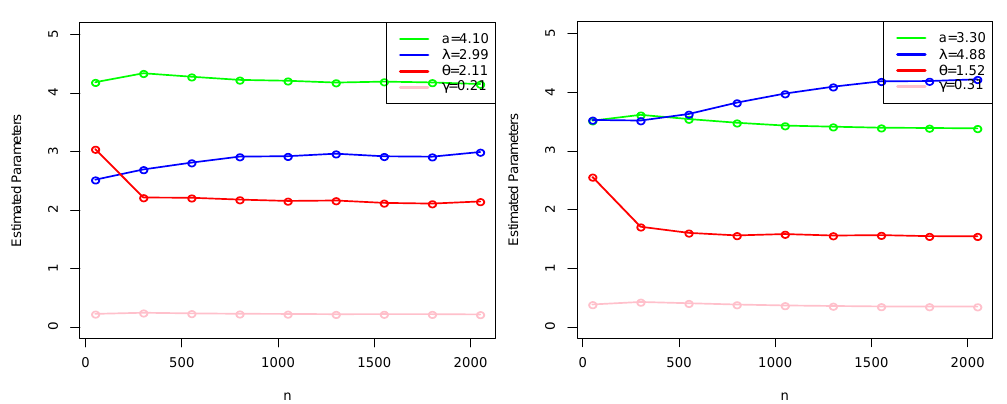
Figure 4. MLE plots of NGE3ED for Set I: a = 4.10, λ = 2.99, θ = 2.11, γ = 0.21 and Set II: a = 3.30, λ = 4.88, θ = 1.52, γ =